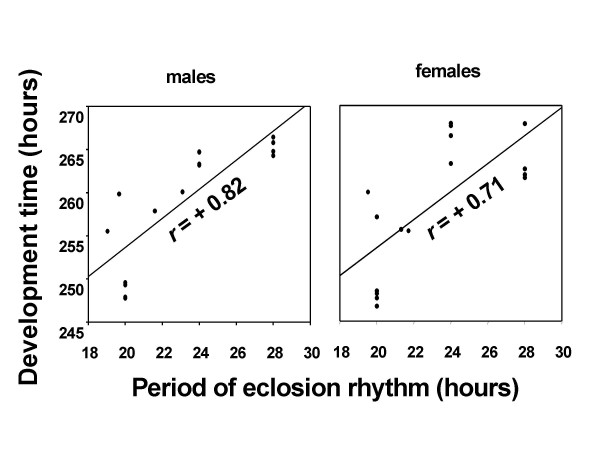
Mean development time and the period of the eclosion rhythm show a significant positive correlation. The mean development time in hours under T20, DD, T24 and T28 is plotted along y-axis, and the period of eclosion rhythm under the corresponding light regime is plotted along x-axis. The correlation between mean development time and period of eclosion rhythm for males is shown in left panel while that for females is illustrated in the right panel.